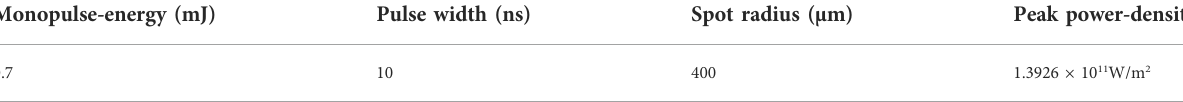
TABLE 1 Parameters of pulsed laser.